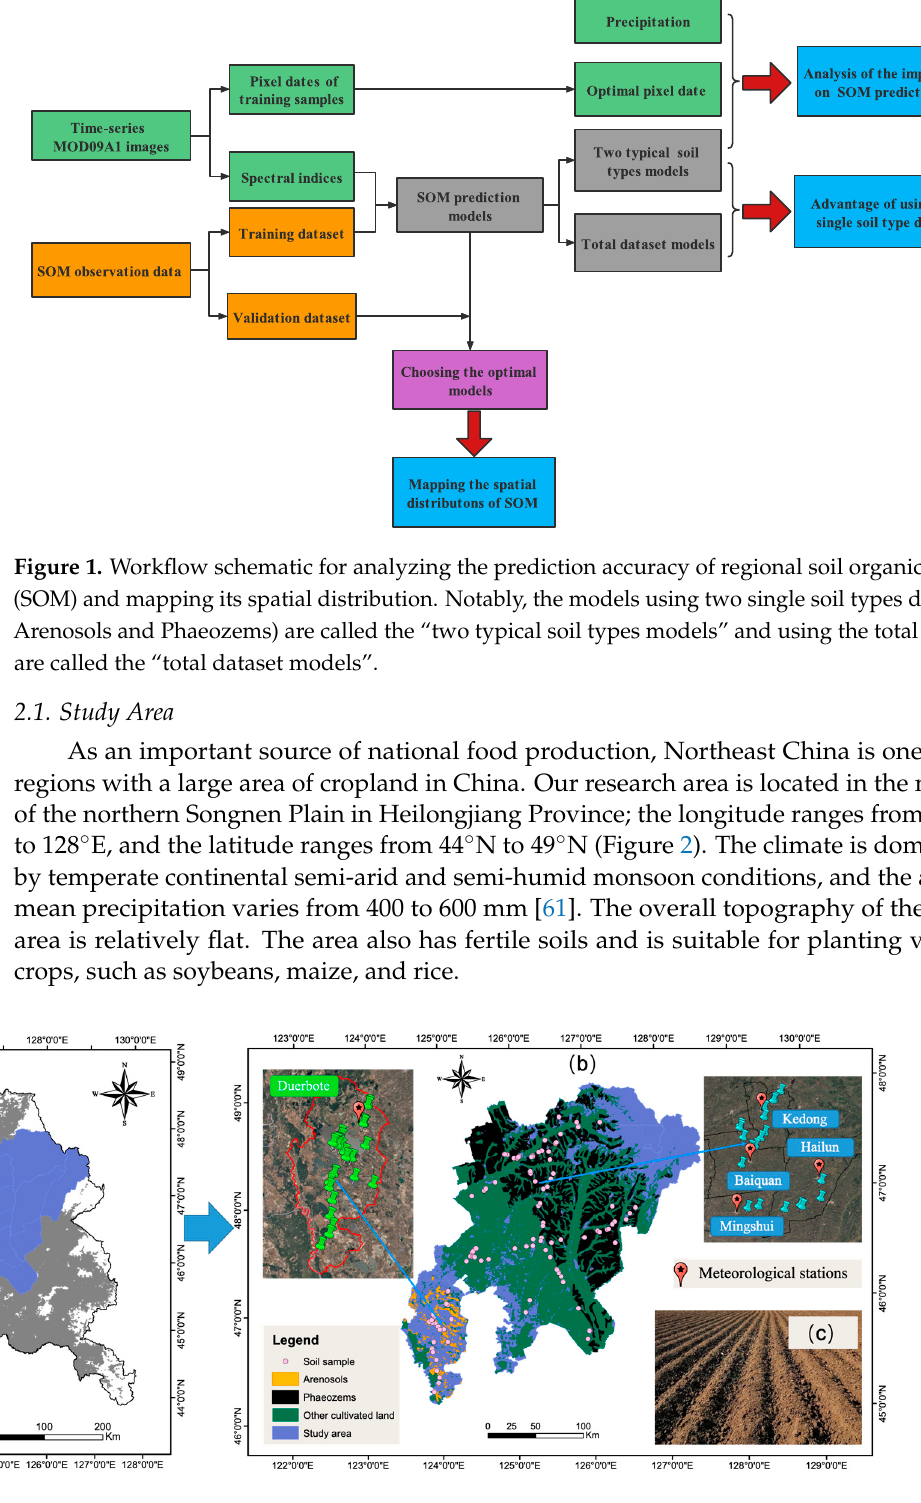
Figure 2. Overview of the northern Songnen Plain and study area ( a ), soil sampling locations of training samples, and main meteorological stations for Arenosols and Phaeozems ( b ). Photograph of the soil surface condition after plowing ( c ).